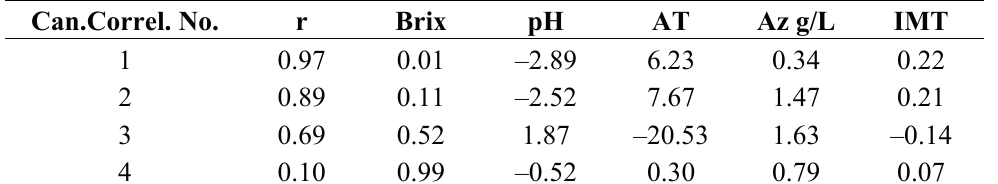
Table 8. CCA coefficients of the first four canonical correlations for white musts of 2012. Can.Correl.